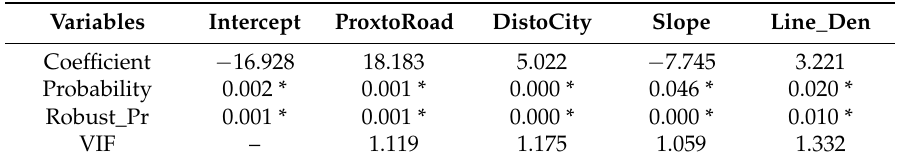
Table 5. Independent variables statistical results. Robust_Pr: robust probability; VIF: variance inflation factor.